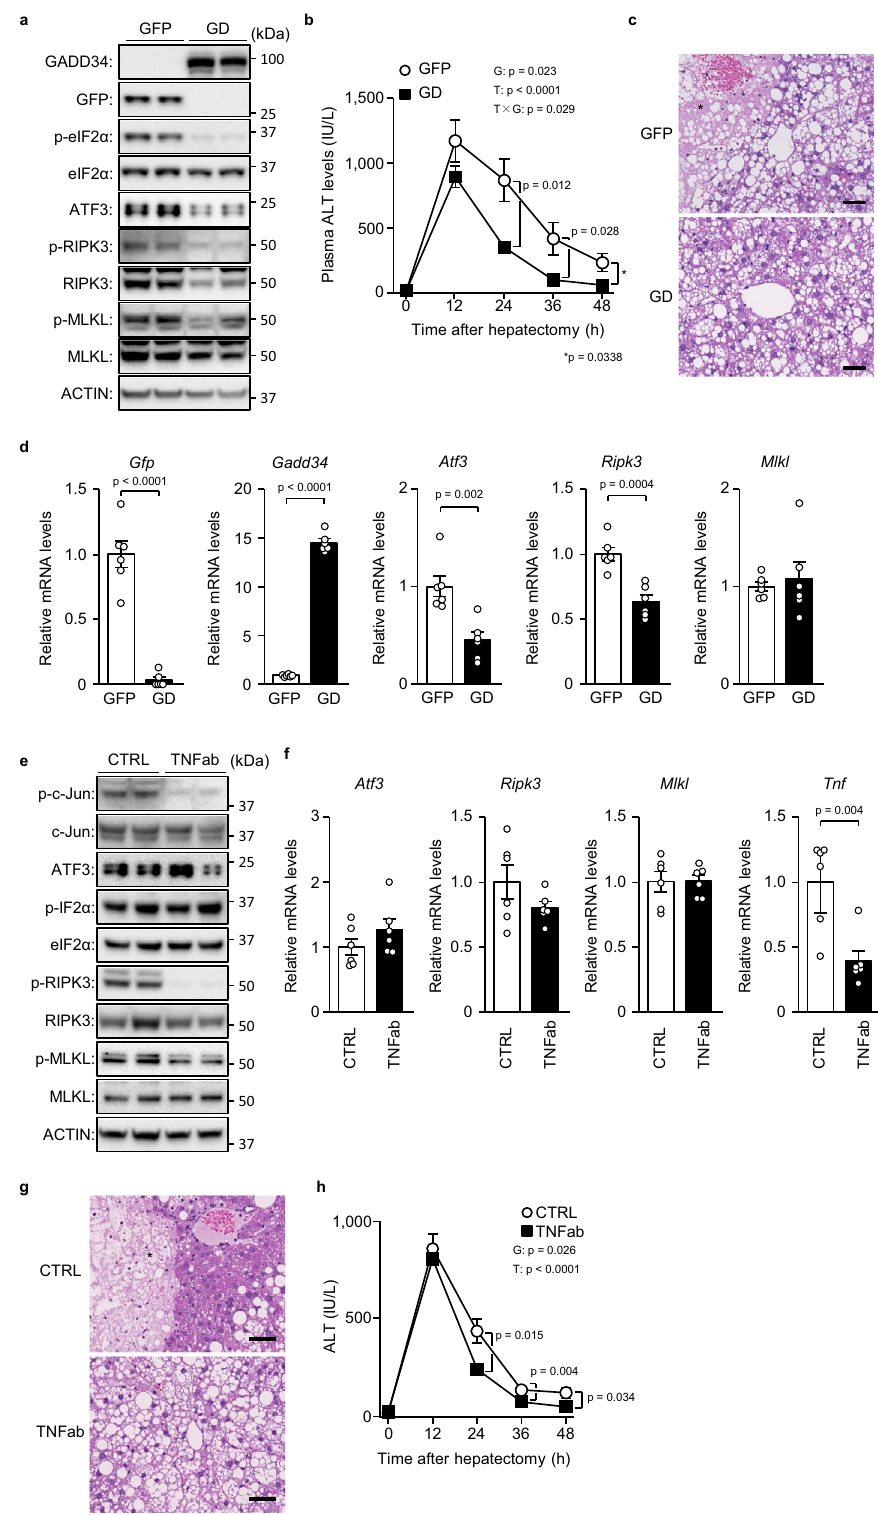
Fig. 5 | eIF2 α dephosphorylation and TNF α neutralisation in hepatic steatosis after hepatectomy. a – d Mice with severe hepatic steatosis overexpressing GADD34 (GD) or GFP by recombinant adeno-associated virus (rAAV) underwent partial hepatectomy. a Immunoblot analysis. b Plasma ALT levels. c Haematoxylin- eosin staining. Scale bar, 50 μ m. Asterisks indicate hepatocellular death foci. d Quantitative PCR analysis. e – h Mice with severe hepatic steatosis underwent partialhepatectomyandwereinjectedwithTNF α -neutralisingantibody(TNFab)or